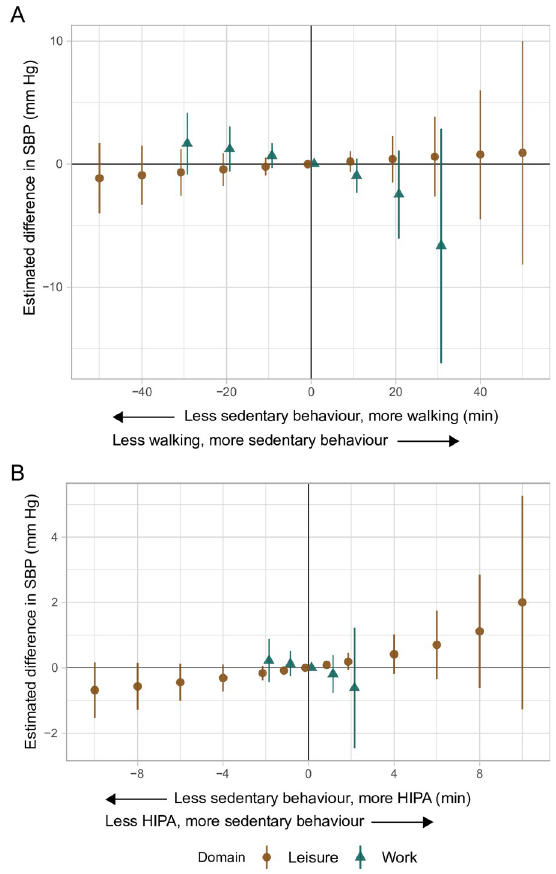
Fig 2. Adjusted estimated differences in systolic blood pressure (mm Hg, y-axis) given the reallocation of time between sedentary behaviour and A) walking, and B) HIPA among 652 adults. A negative value on the x-axis reflects the pairwise reallocation of time from sedentary behaviour to walking or HIPA, while a positive value reflects the reallocation of time from walking or HIPA to sedentary behaviour. The origin represents the reference composition (i.e., 372.7 and 234.2 min sedentary behaviour, 127.0 and 74.6 min standing, 49.1 and 22.5 min moving, 56.8 and 32.5 min walking, and 10.9 and 2.5 min HIPA, during leisure and work, respectively, and 457.3 min in bed). The difference in outcome was calculated by subtracting the estimated outcome of the reference composition from the estimated outcome for each reallocated composition. SBP is systolic blood pressure. HIPA is high-intensity physical activity (i.e., sum of climbing stairs, running, cycling, and rowing). Vertical lines correspond to the 95% confidence intervals.